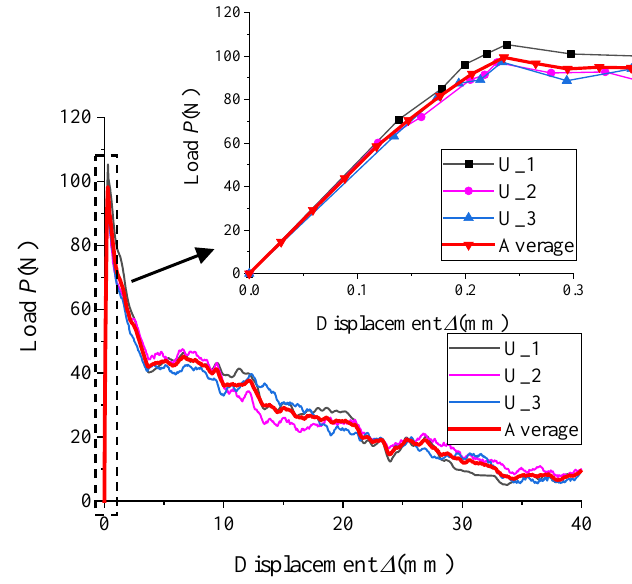
Figure 6. Pullout P - Δ curves: untreated steel fibres (group U).